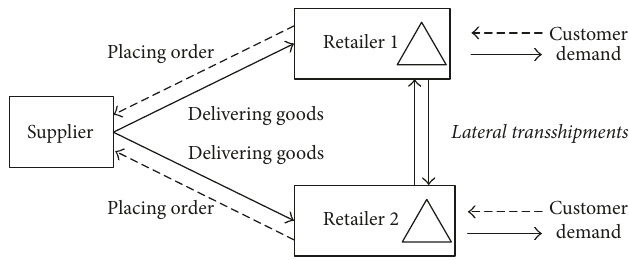
Figure 1: The structure of a supply chain system with lateral